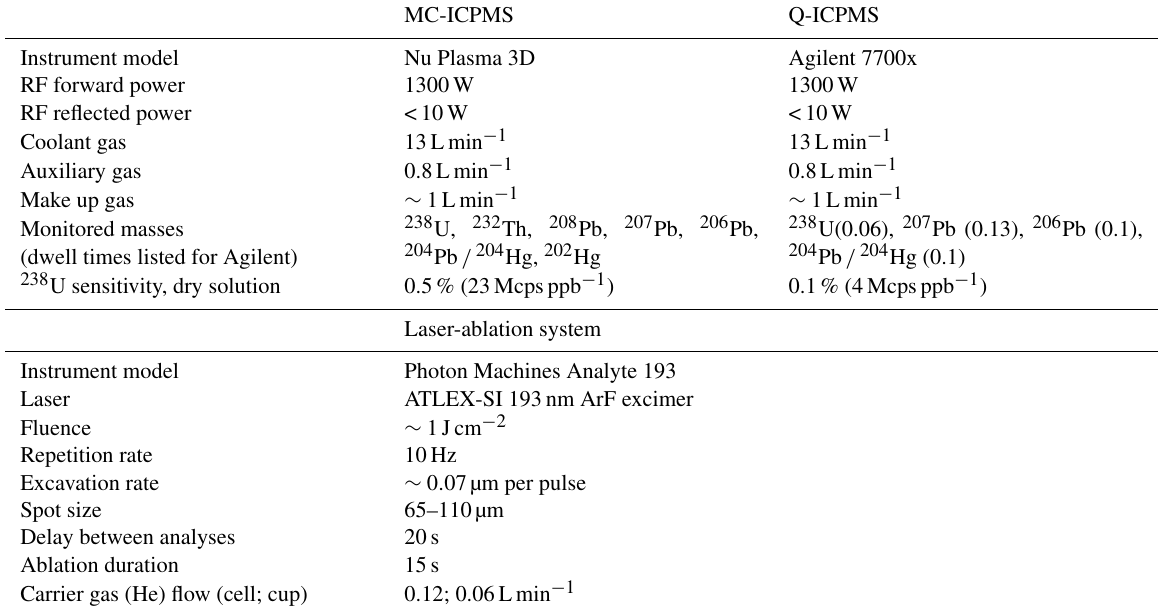
Table 1. Instrumental parameters of laser-ablation split-stream